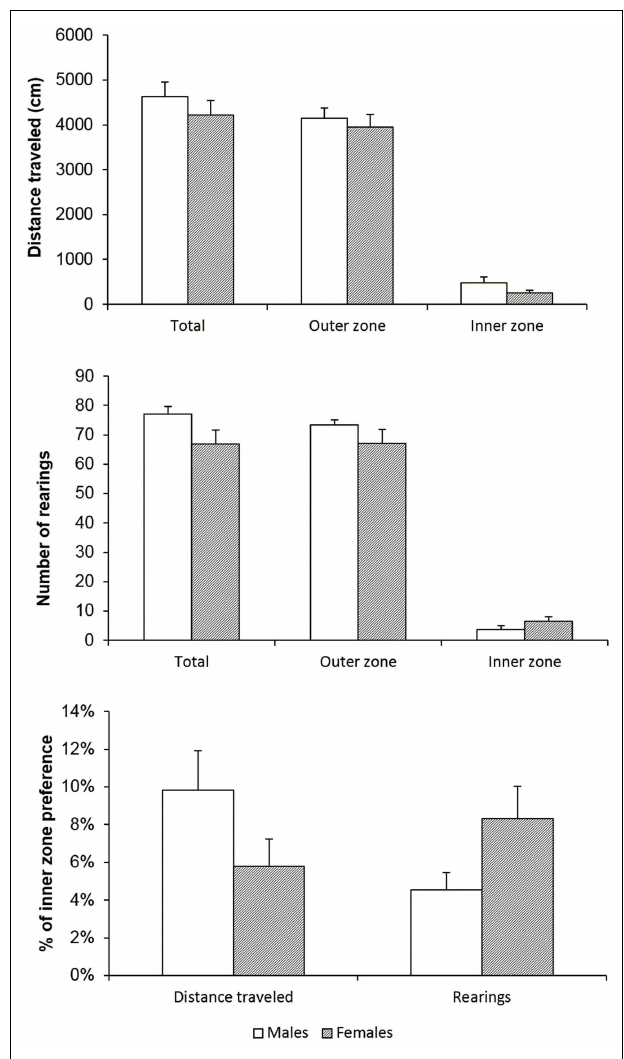
FIGURE 1 | Male and female rats have the same basal behavioral profile . Total distance traveled (in centimeters), number of rearing episodes (vertical activity), and % of preference of the central part of the arena did not reveal any gender difference. Data are shown as means ( (cid:6) SEM), t -test,